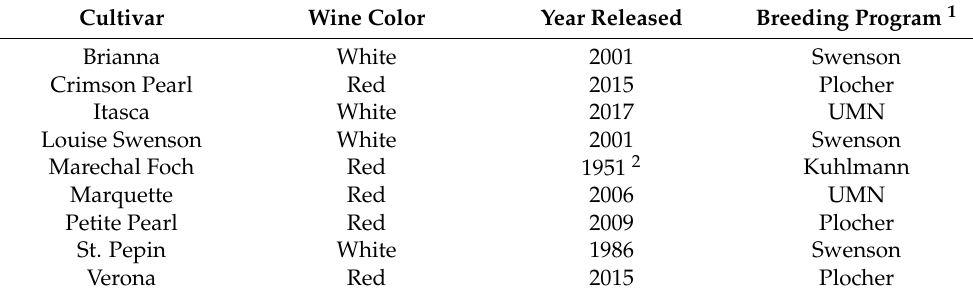
Table 1. Breeding program origination for nine winegrape cultivars evaluated in South Burlington, VT,